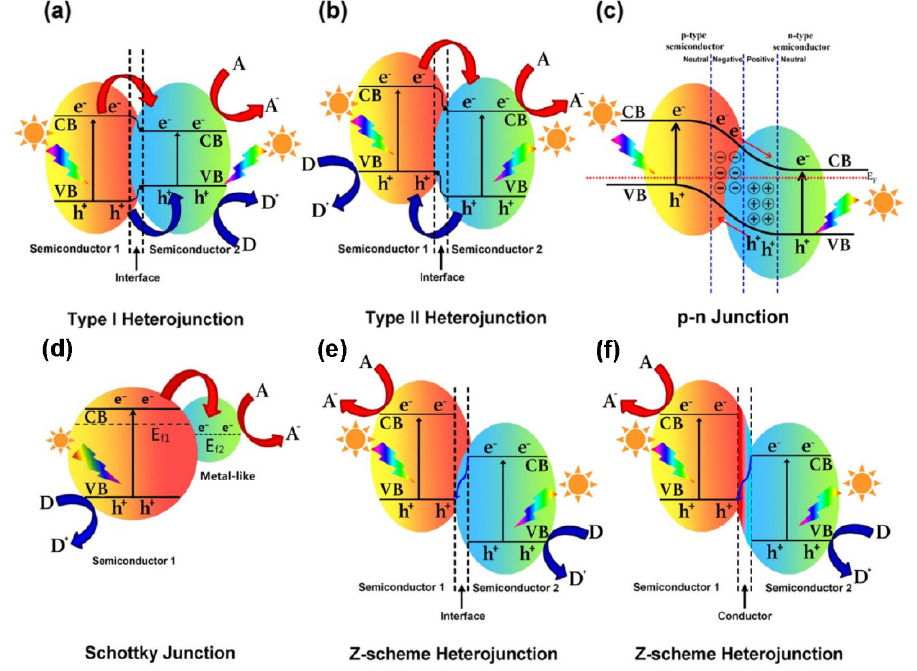
Figure 4. Examples of heterojunction systems. Reproduced from [98], Copyright (2019), with per- mission from